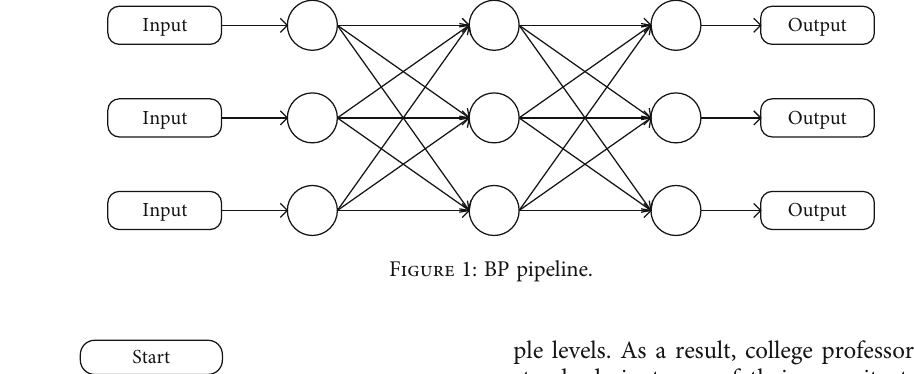
Figure 1: BP pipeline.